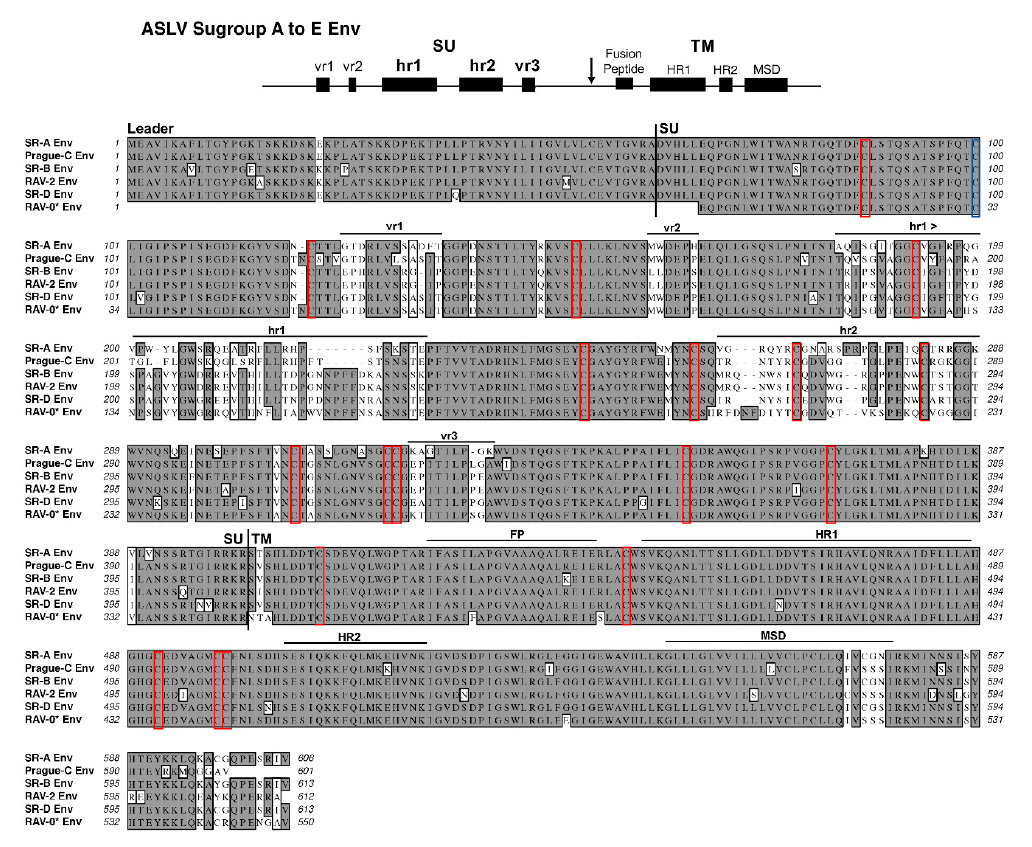
Figure 2. Schematic representations of the major functional domains and comparison of representative Avian Sarcoma and Leukosis Virus (ASLV) subgroups A to E envelope glycoprotein sequences. The envelope glycoprotein leader sequence (Leader), surface glycoprotein sequence (SU), transmembrane glycoprotein sequence (TM) are indicated. The variable region (vr1, vr2, and vr3) and the host range region (hr1 and hr2) sequences in the surface glycoprotein, and the fusion peptide (FP), heptad repeat (HR1 and HR2), and the membrane spanning domain (MSD) sequences in the transmembrane glycoprotein are indicated. The cysteine residues are highlighted in red boxes; the one unpaired cysteine residue at position 100 is highlighted with a blue box. The sequence alignments were done using the ClustalW program in MacVector 14.5.3: identical residues are shaded; conserved residue differences are in boxes, and nonconserved residue differences are unmarked. SR-A: Schmidt–Ruppin A subgroup A ASLV strain UniProt P03397; SR-B: Schmidt–Ruppin B subgroup B ASLV Genbank AAC08989; RAV-2, this study and Genbank AAA87241; Prague-C subgroup C ASLV